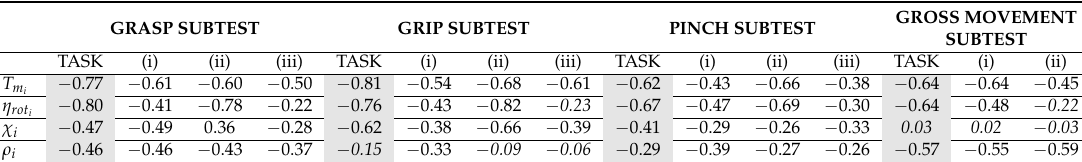
Table 1. Spearman’s rank correlation coefficient ρ S for four ARAT subtest (grasp, grip, pinch, and gross) and four analysed parameters (movement time T m , movement smoothness represented as rotational i jerk index η rot , trajectory similarity χ i , and trunk stability index ρ i ). ρ S for the task is shown in grey i area, followed by (i)–(iii) for each movement phase. Values written with minor italic font are not statistically significant ( p >